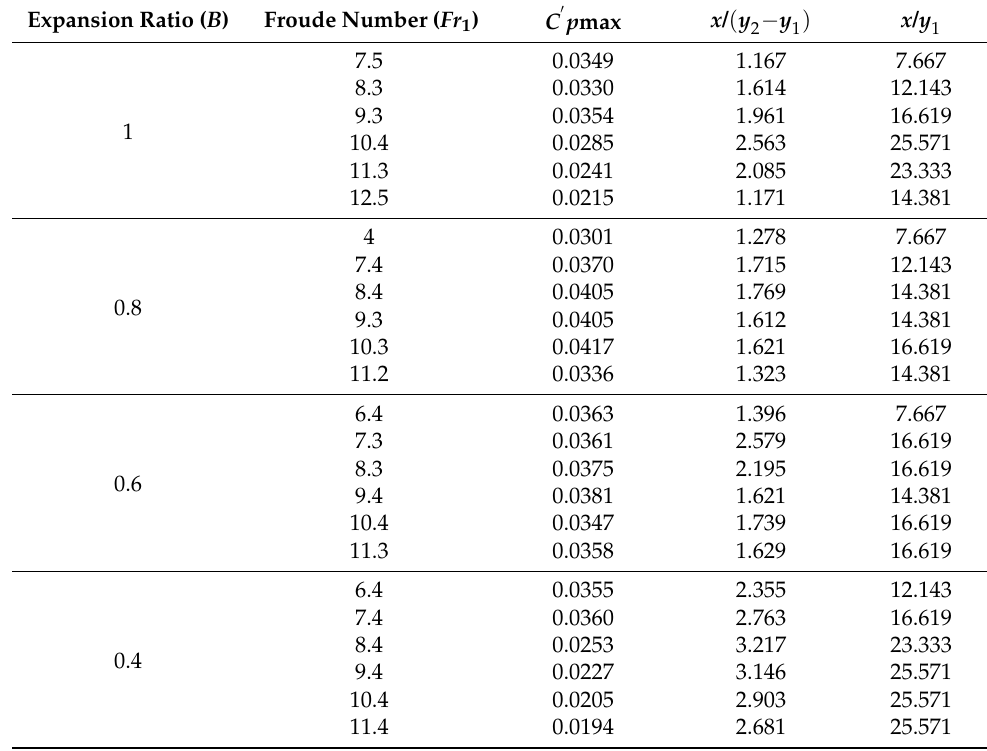
Table 2. Maximum RMS pressure fluctuations measured as a function of Froude